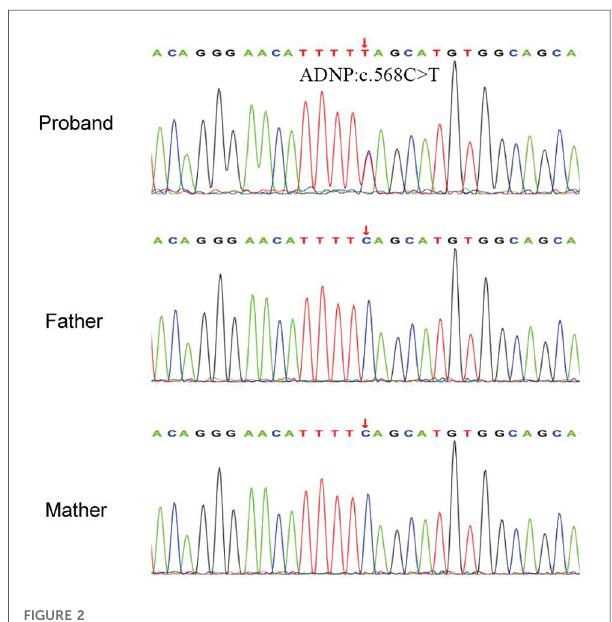
FIGURE 2 Sanger sequencing results of the pedigree. The proband had a heterozygous variant of c.568C>T in ADNP